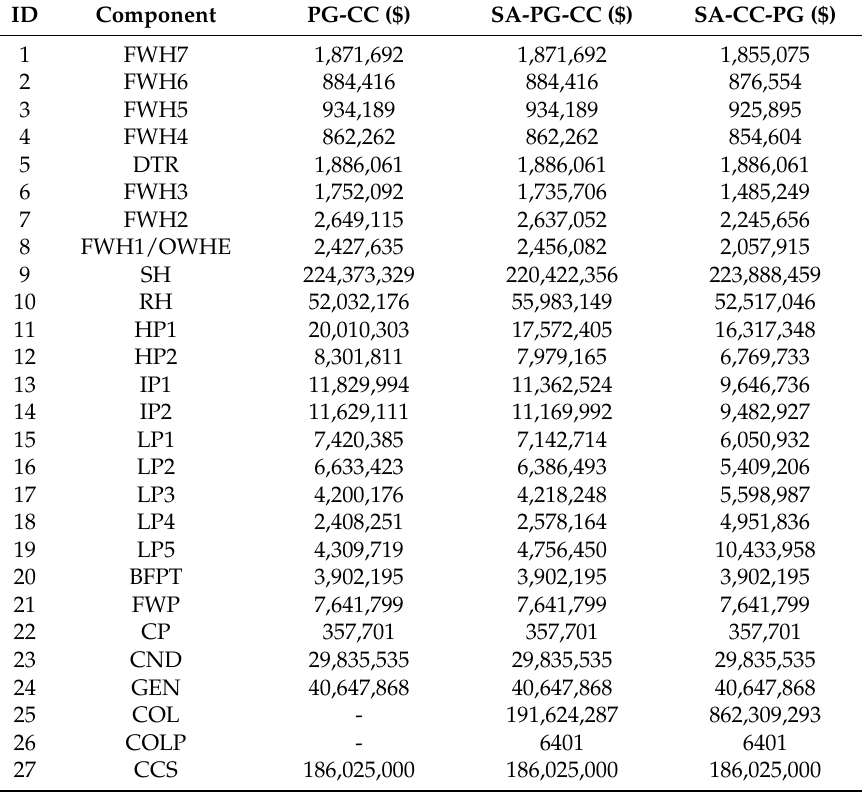
Table A2. Investment of Each Component [48,66].